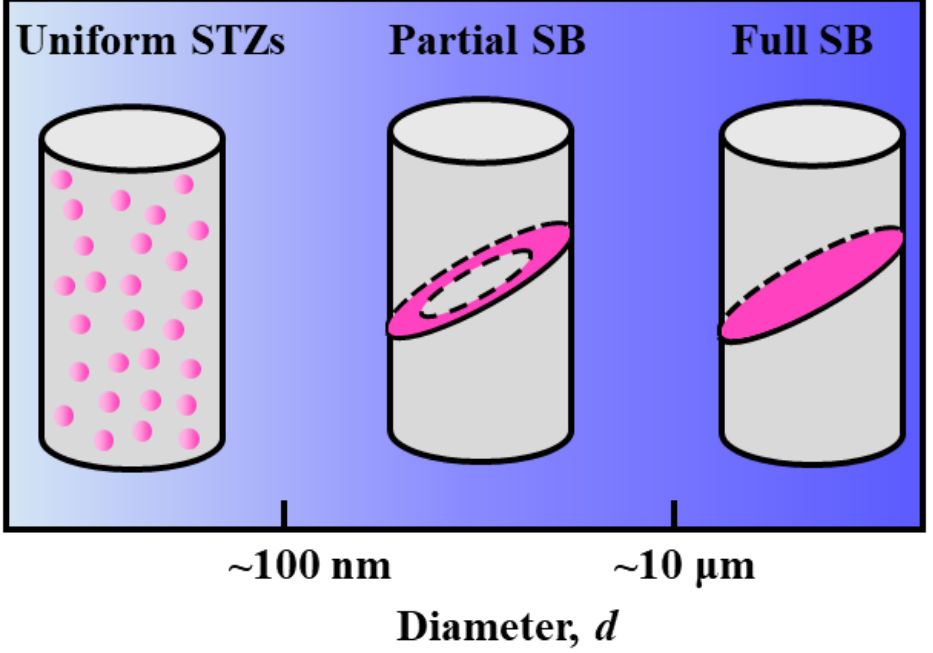
Figure 1. Schematic illustration of the different size regimes and the governing deformation mechanisms in MGs; namely the full SB in submillimeter-sized MGs, the partial SB in micron-sized MGs, and the homogeneous deformation in nanoscale MGs.